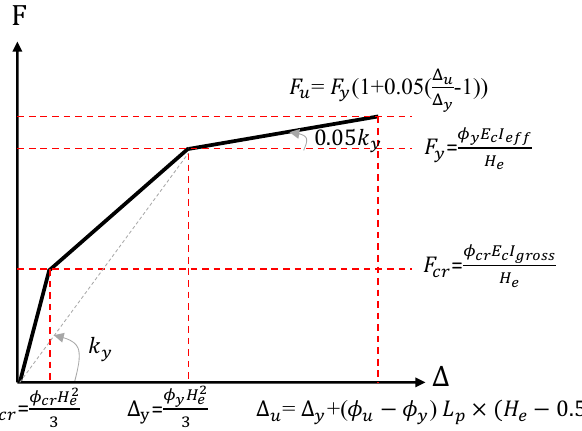
Figure 5. Trilinear pushover